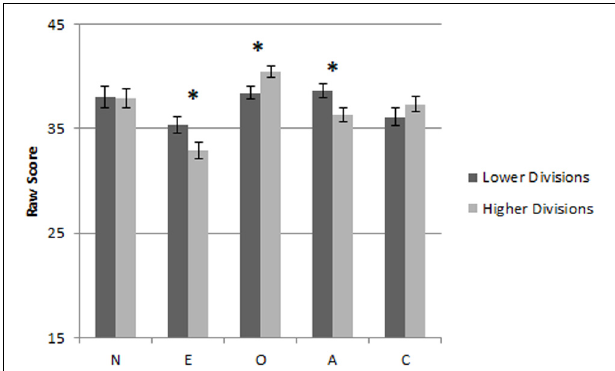
FIGURE 1 | Personality traits raw scores comparison between lower and higher divisions.